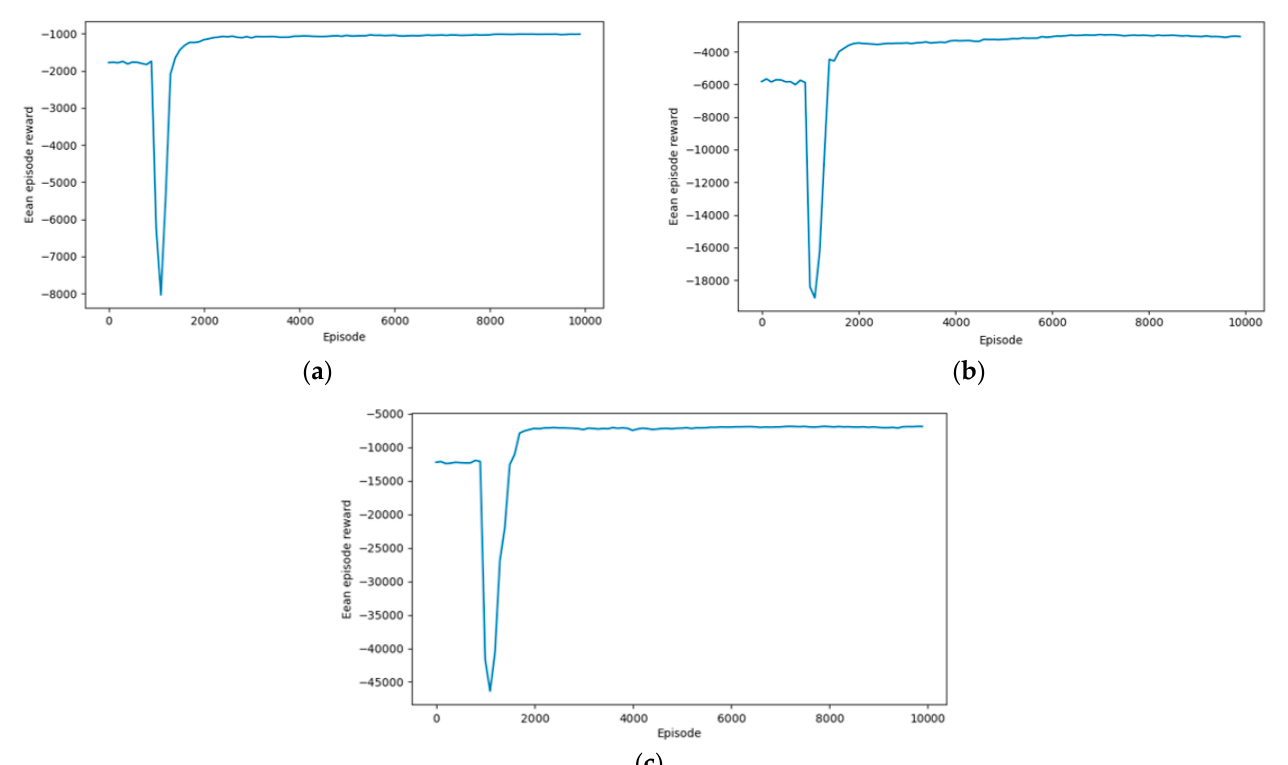
Figure 7. The reward of multiple cooperative USVs with formation generation policies for 40,000 episodes with different numbers of USVs: ( a ) mean episode reward for 3 USVs during formation generation policies training over 10,000 epi- sodes; ( b ) mean episode reward for 5 USVs during formation generation policies training over 20,000 episodes; ( c ) mean episode reward for 7 USVs during formation generation policies training over 10,000